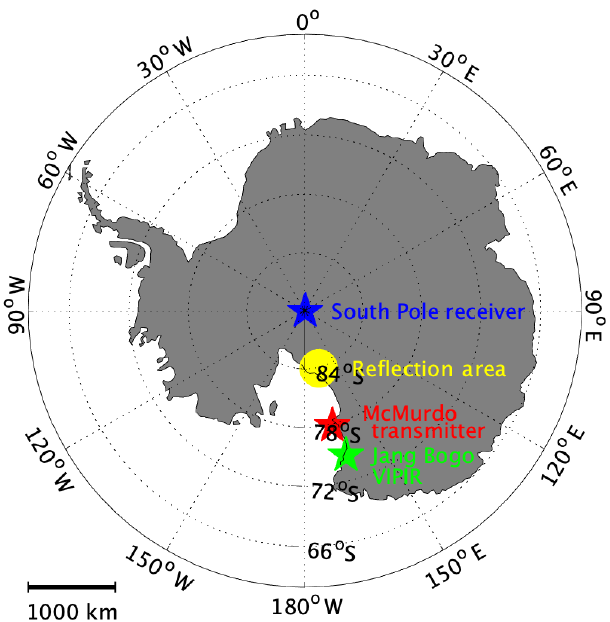
Figure 1. Experimental configuration with transmitter at McMurdo (red), receiver at South Pole (blue), approximate ionospheric reflec- tion area (for single hop propagation) at midpoint between them (yellow), and validation instrument (VIPIR) at Jang Bogo station